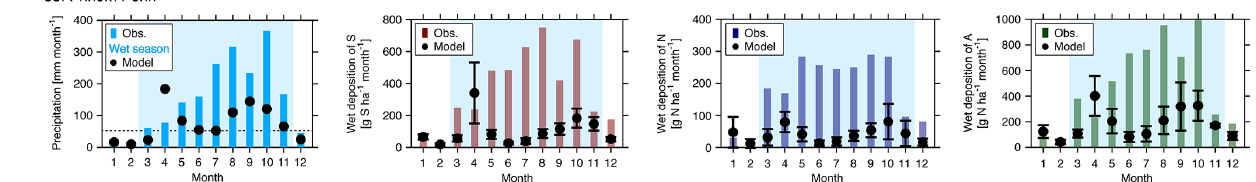
Figure 4. Monthly accumulated precipitation and wet depositions of S, N, and A in Phnom Penh, Cambodia. Whiskers represent the standard deviation among the seven models, and the wet season (light blue color) is defined as months when precipitation exceeded 50mm. Table 5. Statistical analysis of the model performance for Phnom Penh, Cambodia. Wet deposition of S Wet deposition of N Wet deposition of